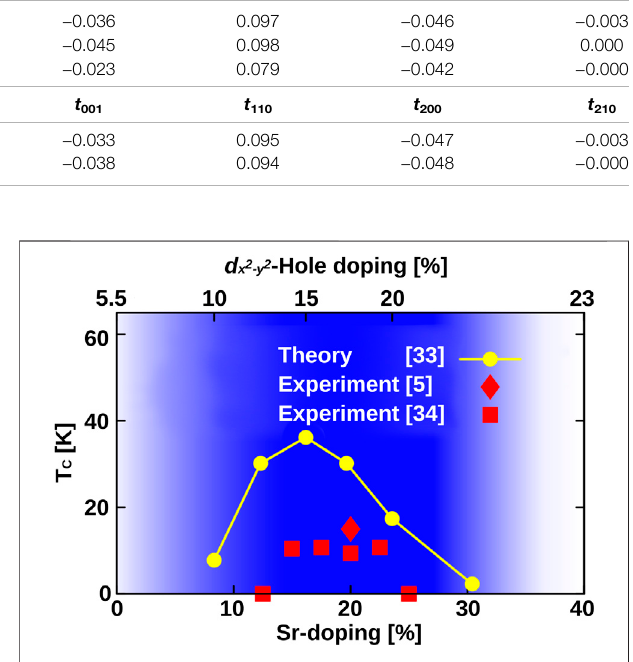
FIGURE 5 | Superconducting phase diagram T c vs. x for Sr x Nd 1 − x NiO 2 as predicted byD Γ A [33] and experimentally con fi rmed a posteriori in [34, 35]. A priori, that is, at the time of the calculation, only one experimental data point [5] was available. For such a dif fi cult to determine quantity as the superconducting T c and without adjusting parameters, the accuracy is astonishing. The bottom x -axis shows the Sr-doping and the top x -axis the calculated hole doping of the 3 d x 2 − y 2 band according to Figure 4 . Adjusted from